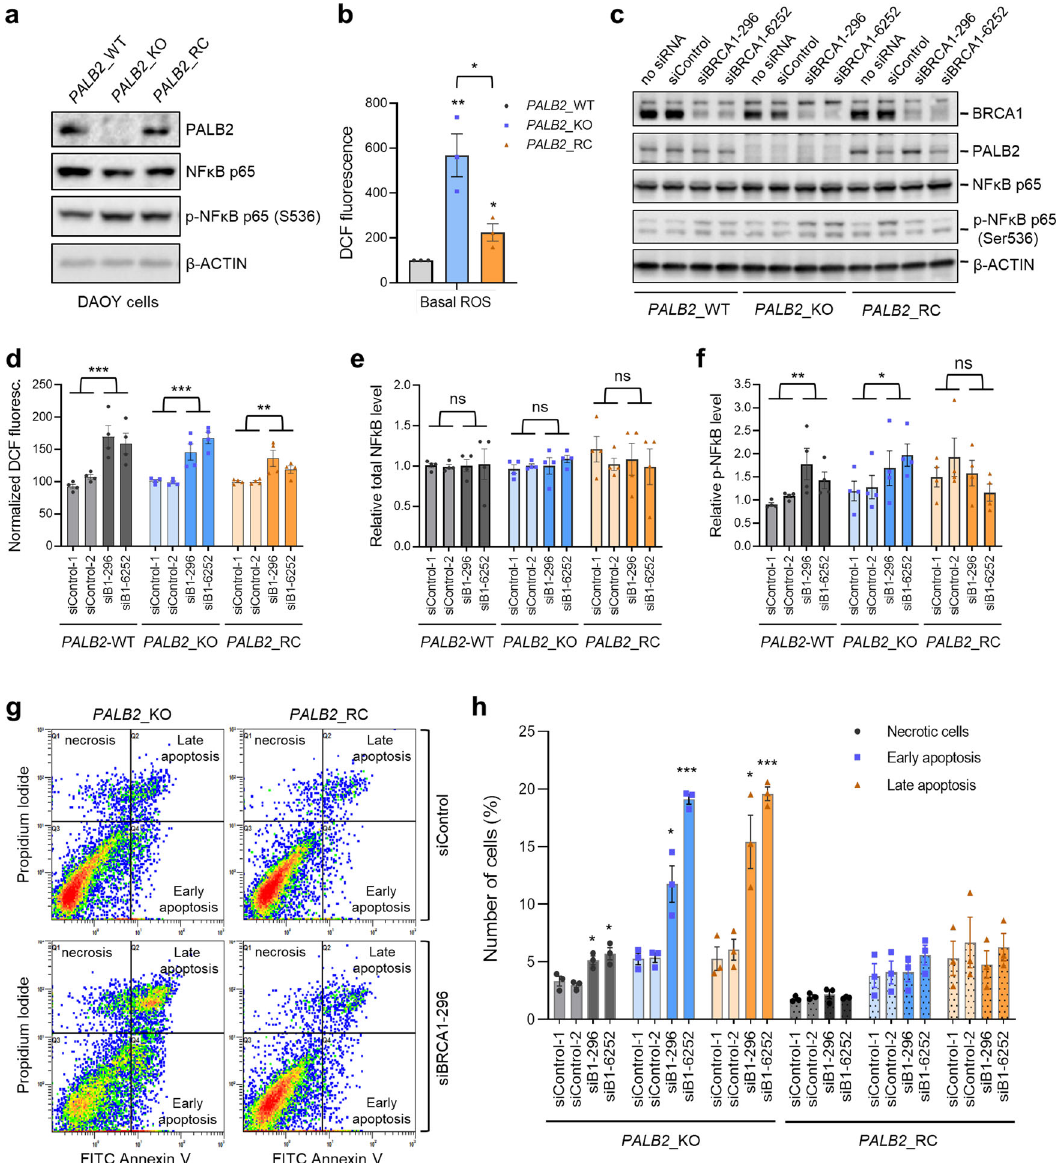
human PALB2 cDNA ( PALB2 -RC). A representative clone was used for each genotype. The PALB2 -WT clone was a false positive PALB2 -KO clone obtained after CRISPR-mediated genome editing. b ROS levels in the three cell lines in ( a ), as measured by the DCF assay. ( c ) Western blots showing levels of BRCA1, PALB2, NF κ B p65, and phospho-NF κ B p65 (S536) in the three cell lines after treatment with transfection reagent alone (no siRNA), a control siRNA, or two different siRNAs targeting BRCA1 . d Relative ROS levels in the three cell lines treated with two different control or BRCA1 siRNAs. Data from each cell line were normalized separately, against the mean of the two control siRNAs. d , e Quanti fi cation of levels of NF κ B p65 and phospho-NF κ B p65 (S536) in the three cell lines after treatment with two different control or BRCA1 siRNAs. Data are normalized against the average of the two control siRNAs for PALB2 -WT cells. g , h Apoptosis and necrosis of PALB2 knockout and reconstituted DAOY cells following depletion of BRCA1. Representative Annexin V assay results are shown in ( g ) and quanti fi cation in ( h ). At least three independent experiments were conducted for all quanti fi cations. Error bars represent SD. * p < 0.05; ** p < 0.01; *** p <